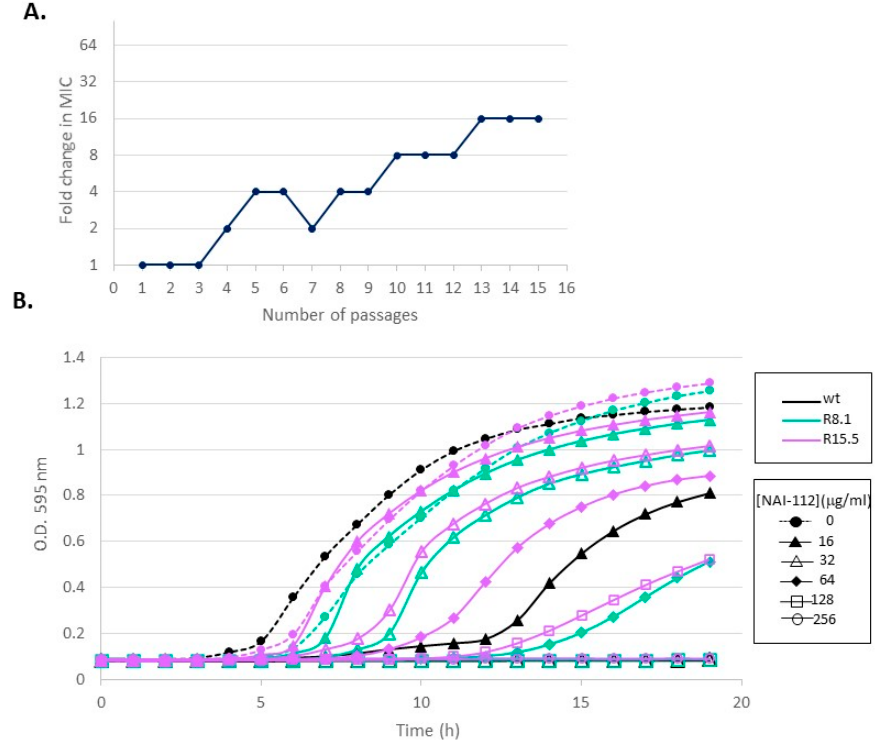
Figure 5. NAI ‐ 112 ‐ resistant mutants. ( A ) Relative change in NAI ‐ 112 MIC after serial passages of S. aureus ATCC 6538P. The starting MIC was 32 μ g/mL. ( B ) Growth of the wild type (wt) and two mutants selected after the 8th (R8.1) and the 15th (R15.5) passage from the experiment in panel ( A ). See the Isolation of NAI ‐ 112 ‐ Resistant Mutants section for details.